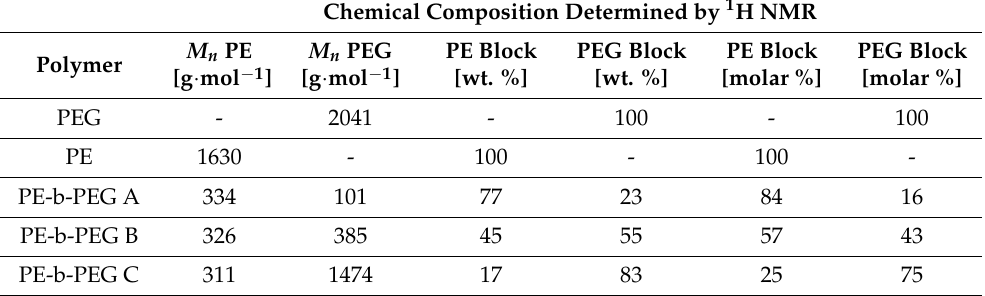
Table 1. Molecular weight M n and chemical composition of studied polymers verified by proton nuclear magnetic resonance ( 1 H NMR). Polyethylene-b-polyethylene glycol copolymers PE-b-PEG A, B and C are characterized by a PE block of constant length and a varying PEG block length. Chemical Composition Determined by 1 H